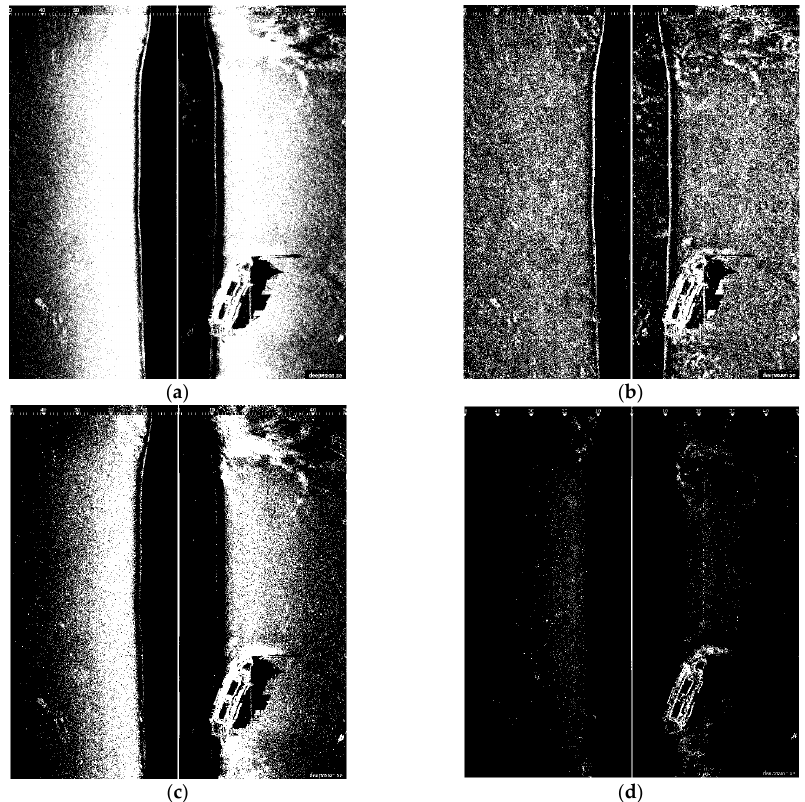
Figure 4. ( a ) Traditional Otsu TSM, Th = 0.3216; ( b ) Local TSM, Th = 0.1628; ( c ) Iterative